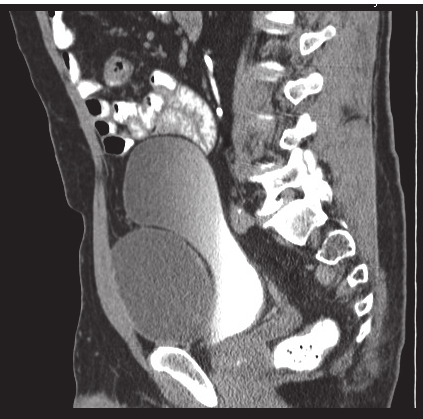
Figure 1: Sagittal computer tomography scan: a giant fluid collec- tion of almost 16 centimeters in diameter is seen ventrally of the bladder in Retzius’ space, evidently compressing the bladder.